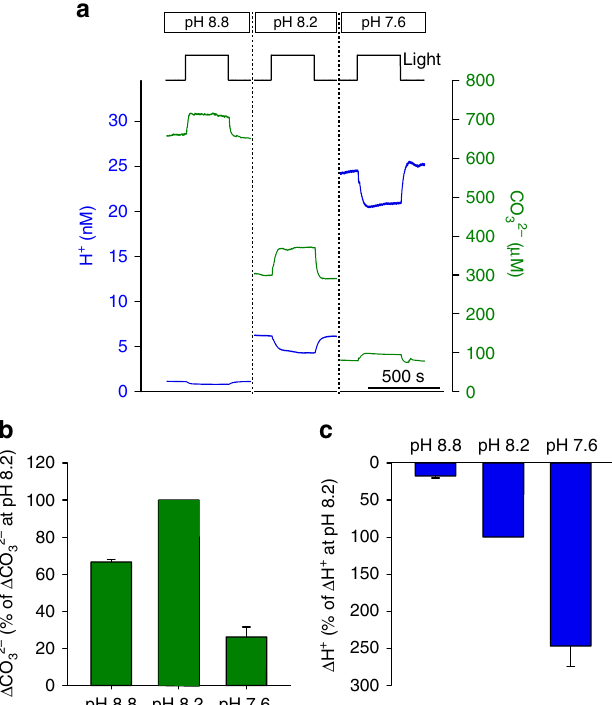
Fig. 8 Cell surface carbonate chemistry at altered seawater pH. a Simultaneous measurement of cell surface [H + ] and [CO 3 2 − ] around an O. sinensis cell in ASW media at pH 8.8. Measurements around the same cell were then taken after the ASW media was bubbled with CO 2 to reduce the pH sequentially to 8.2 and 7.6. b Mean light-dependent changes in cell surface [CO 3 2 − ] in ASW media at pH 8.8, 8.2 and 7.6. c Mean light- dependent changes in [H + ] for the cells shown in b . The results are shown as percentage of the light-dependent changes observed at pH 8.2 to normalise for variability in the photosynthetic activity between individual cells. n = 3 cells. Error bars represent